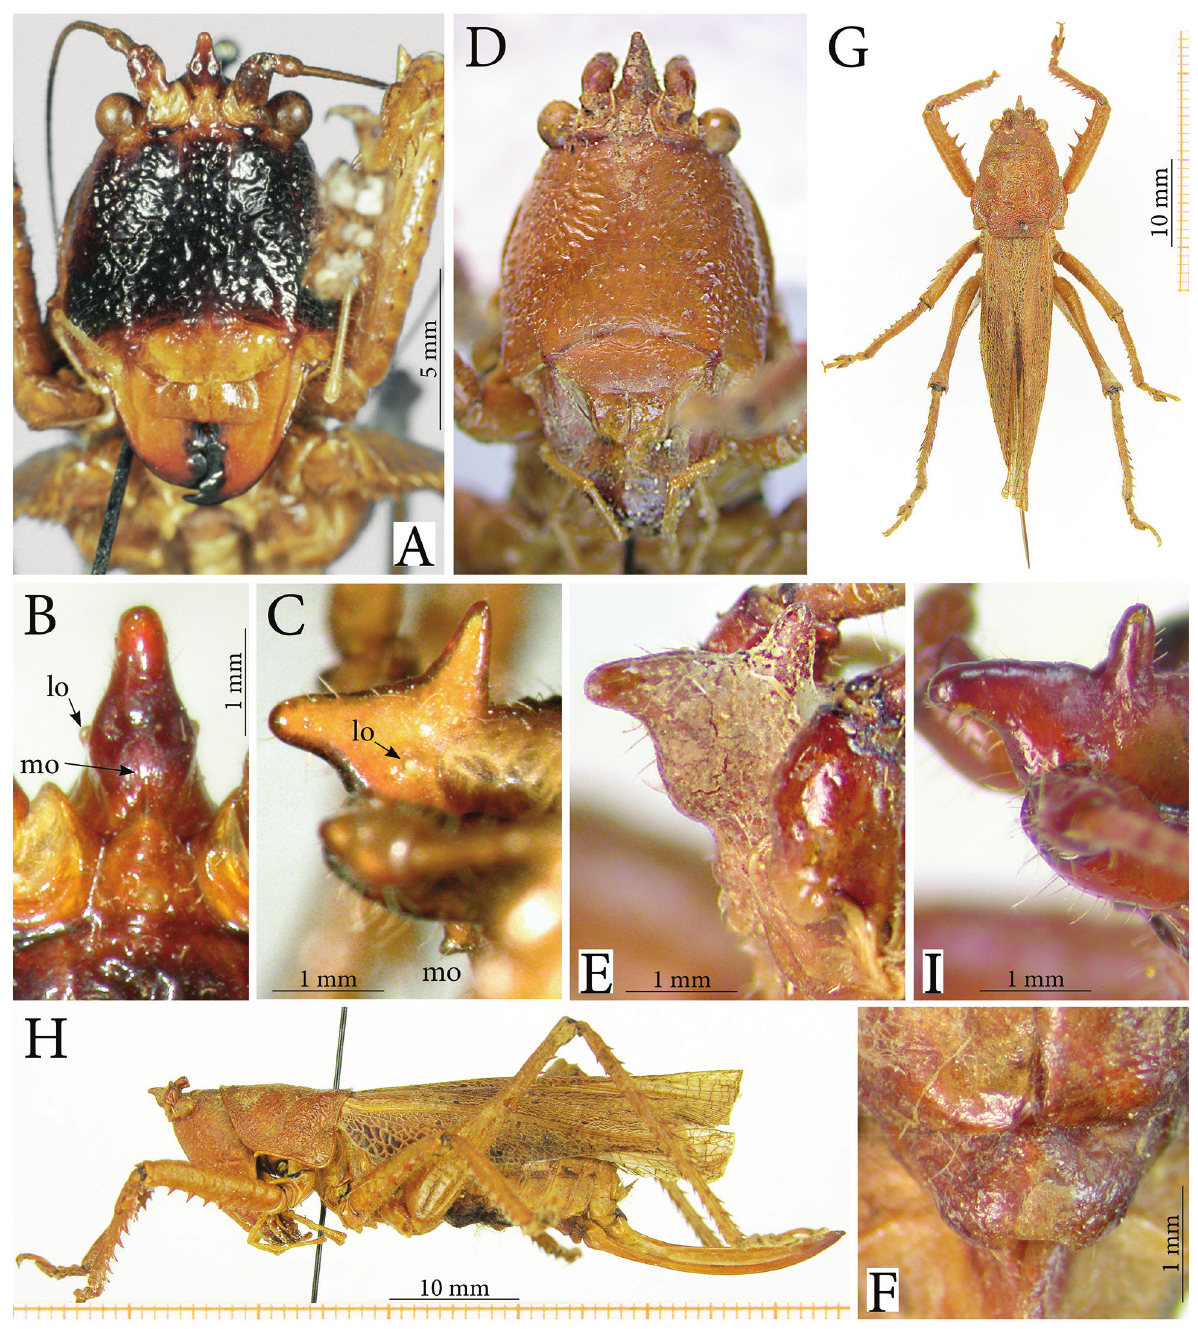
Figure 2. Peracca ( Robustacca ) subgen. nov.: A–C P. ( R. ) nigrifrons sp. nov. female holotype: A face; B fastigium verticis in ven- tro-anterior view and C in lateral view. – D–I P. ( R. ) robustus (Karny, 1923) comb. nov. female holotype ( D–H ) and male from SE Pahang ( I ) D Face; E fastigium verticis in lateral view; F female subgenital plate; G habitus dorsal view; H habitus lateral view; I fastigium verticis. Abbreviations: lo lateral ocellus, mo medium